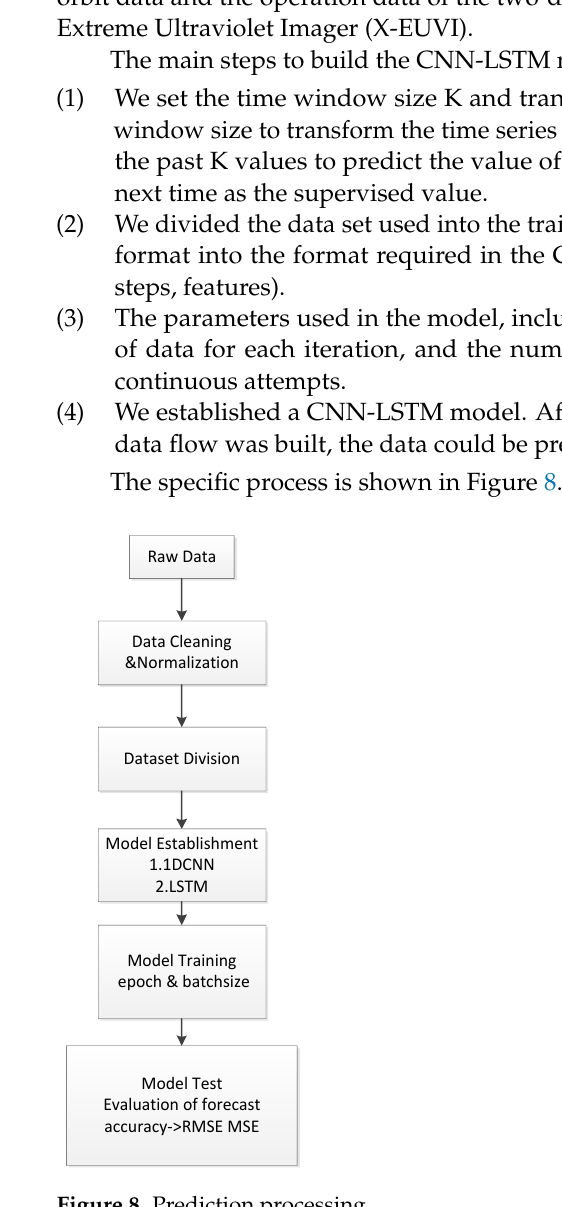
Figure 8. Prediction processing.